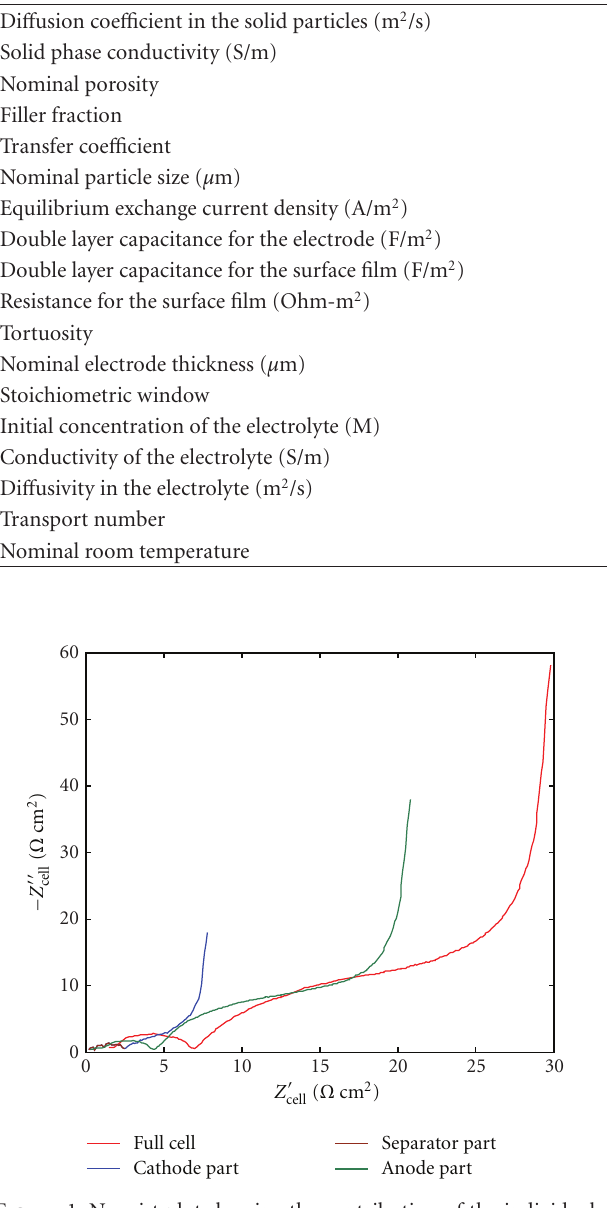
Figure 1: Nyquist plot showing the contribution of the individual cell components towards the overall impedance of the cell at a full cell SOC value of 0.5, between 10 6 and 10 − 4